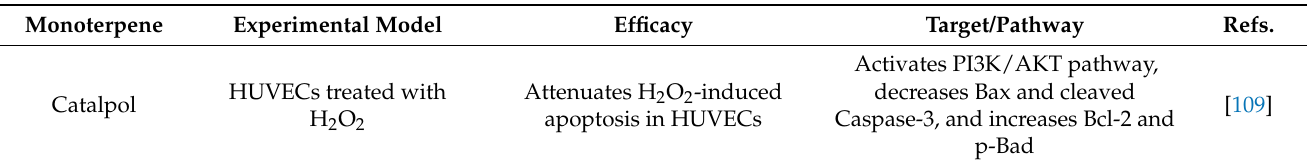
Table 4. Attenuation of endothelial cell